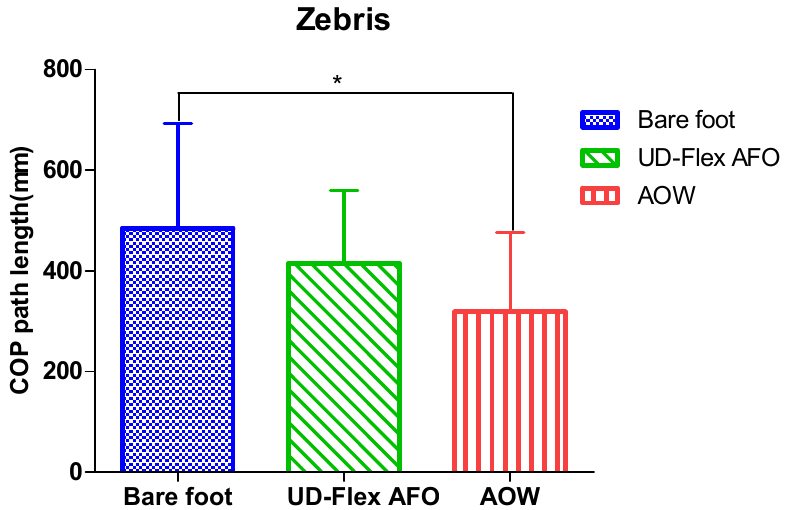
Figure 5. Comparisons of static balance among the three conditions using Zebris. AFO: ankle–foot orthosis; AOW: ankle–foot orthosis with wire; COP: center of pressure. * p < 0.05.